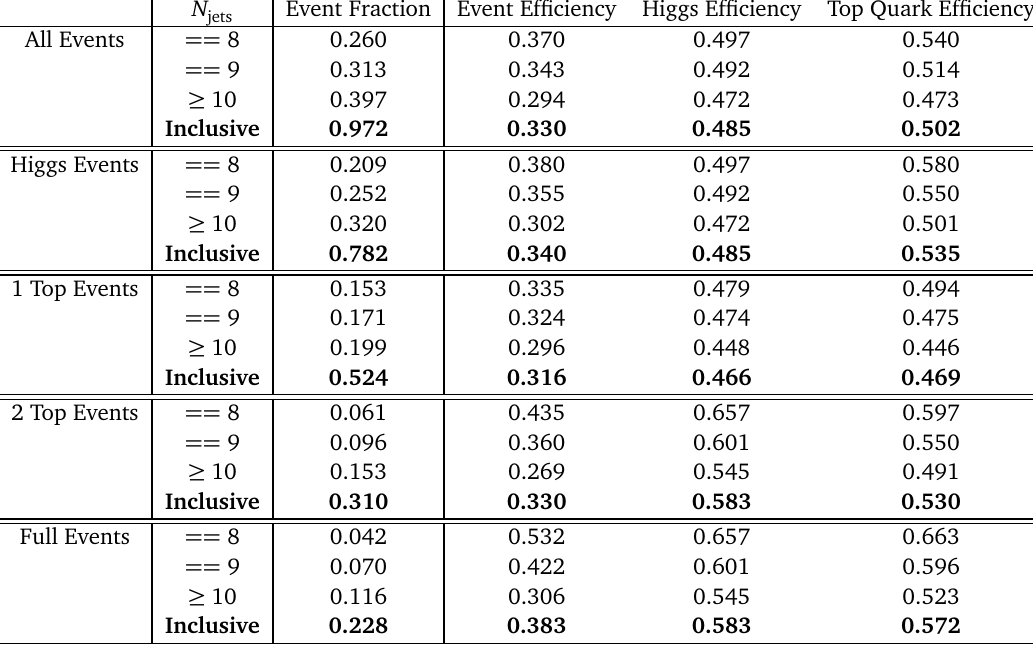
Table 11: S PA -N ET results on t ¯ tH with at least 4 b -tagged jets (filtered